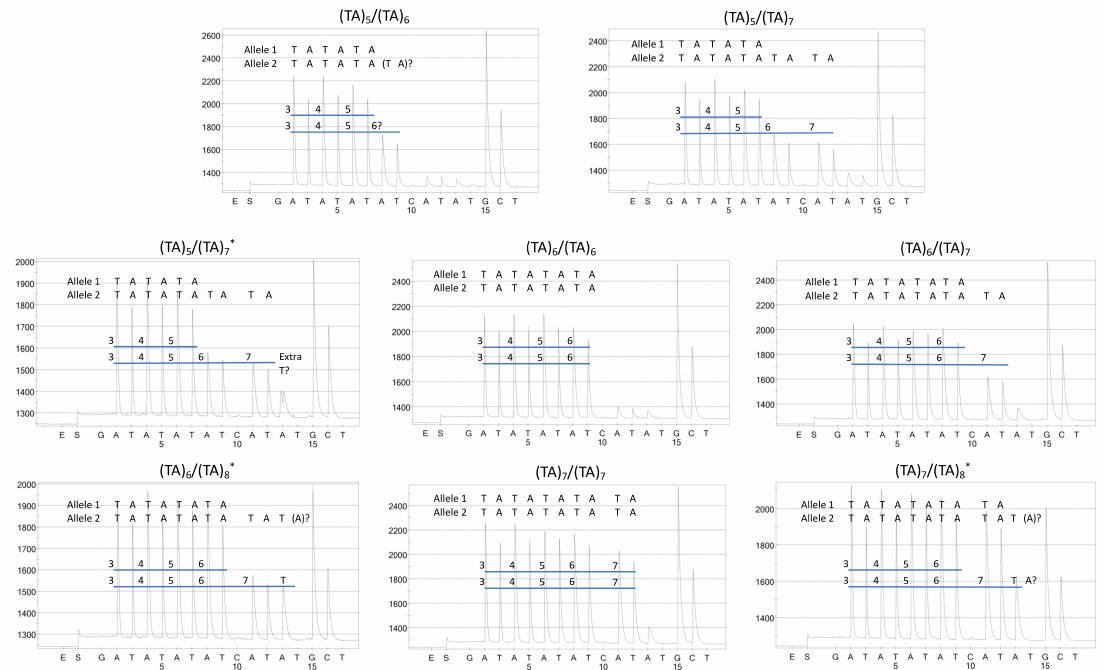
Figure 4. Pyrograms from representative genotypes (as called by MiSeq, fragment analysis, and / or fPCR): ( A ) UGT1A1*36 / *1 , ( B ) UGT1A1*36 / *28 , ( C ) UGT1A1*36 / *28 (ambiguous), ( D ) UGT1A1*1 / *1 , ( E ) UGT1A1*1 / *28 , ( F ) UGT1A1*1 / *37 , ( G ) UGT1A1*28 / *28 , ( H ) UGT1A1*28 / *37 . * The